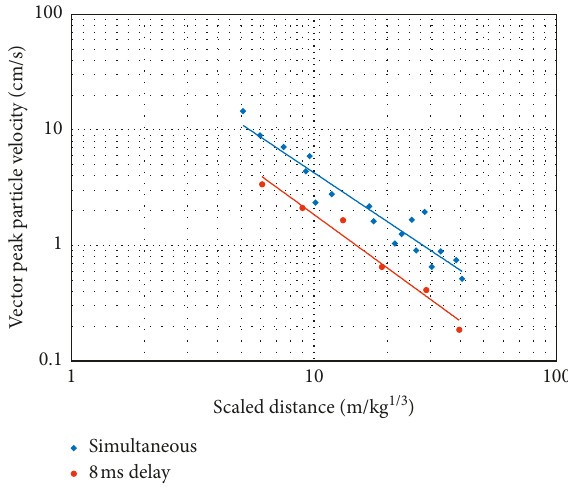
Figure 8: PPV between simultaneous blasting and short-delay blasting.